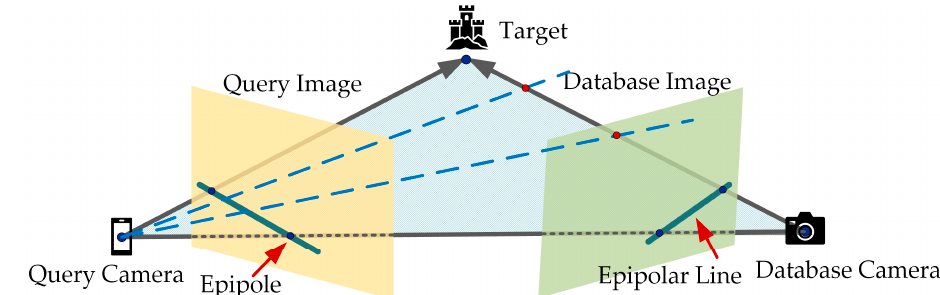
Figure 4. Epipolar